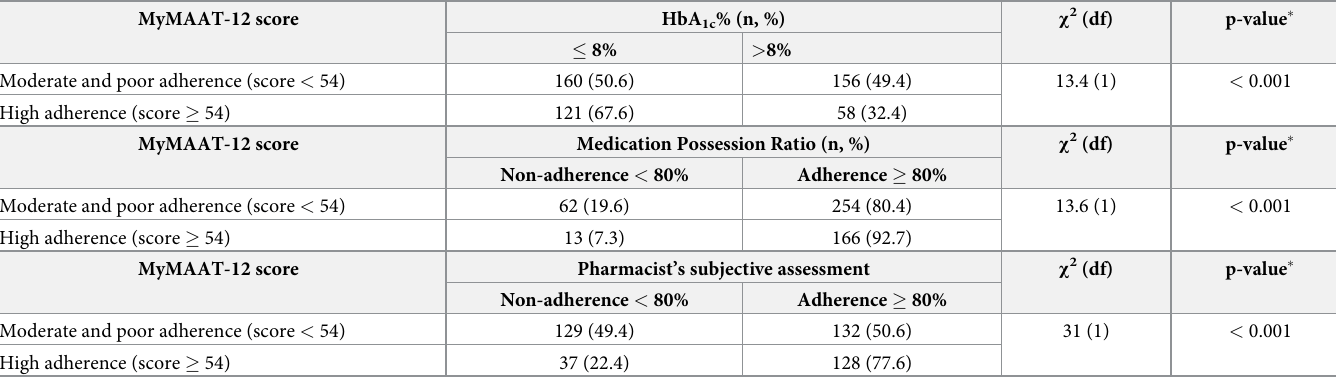
Table 6. MyMAAT-12 categories’ known groups validity.